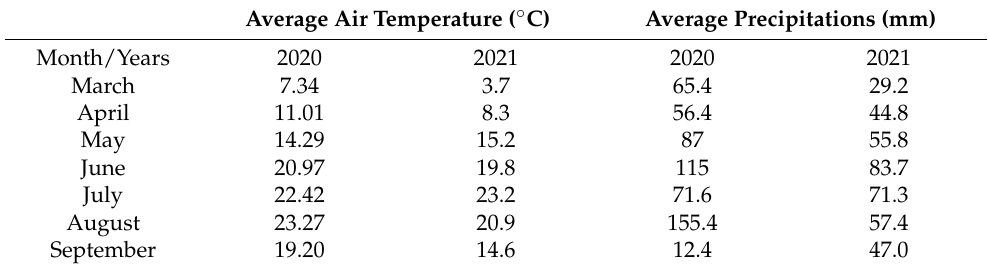
Table 2. Climatic conditions of 2020 and 2021 in the forest–steppe region of Moldavia, Romania.